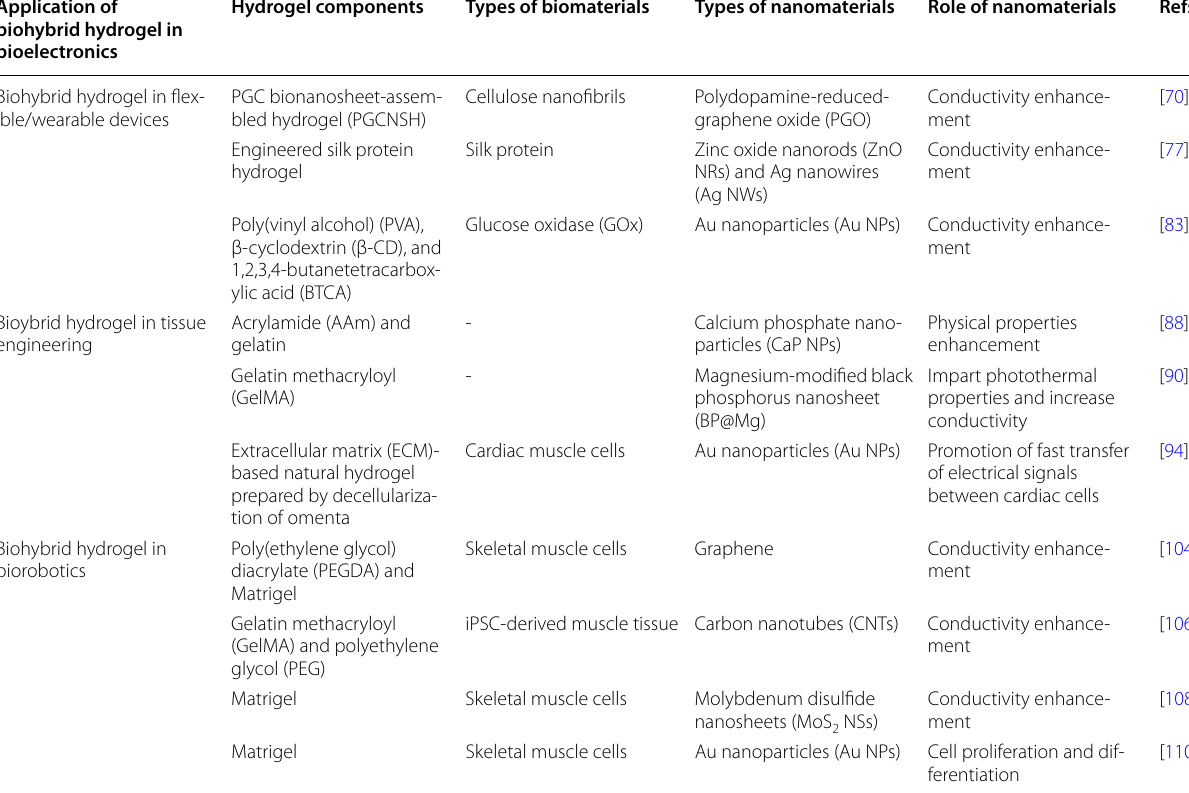
Table 2 Bioelectronics using biohybrid hydrogels Application of biohybrid hydrogel in